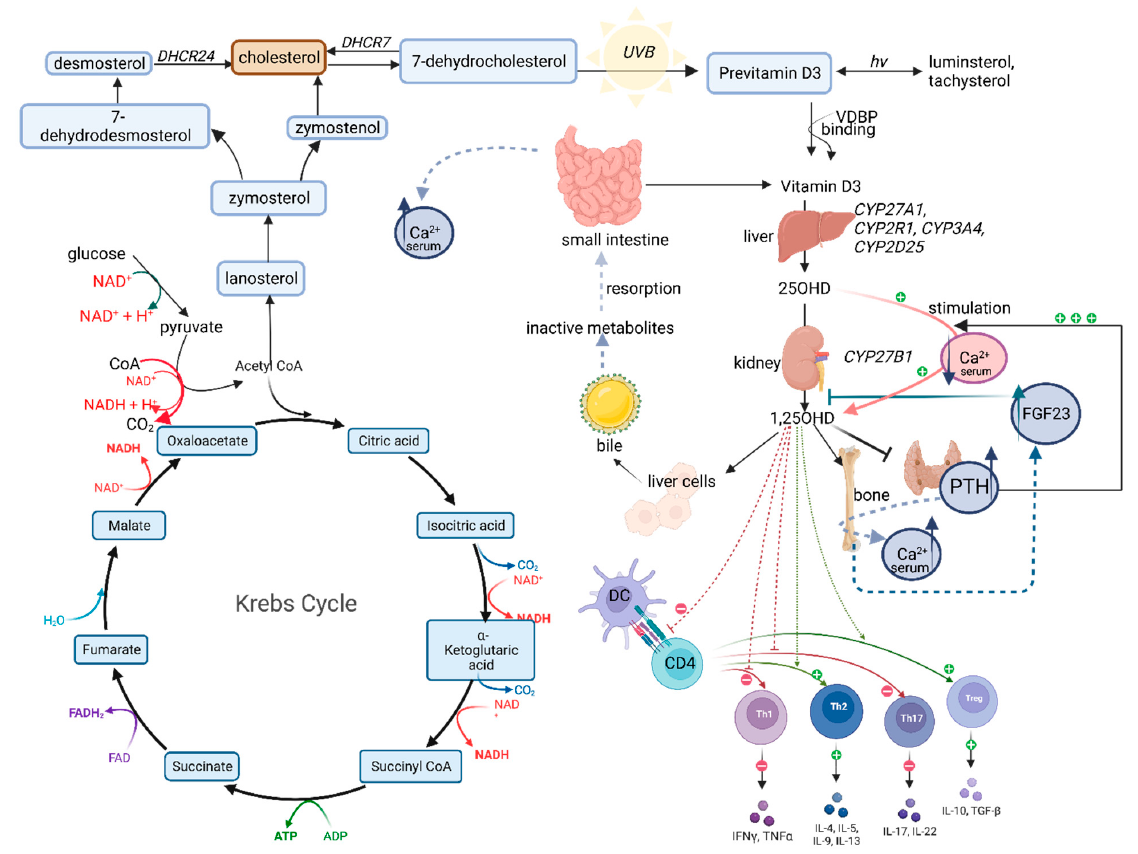
Figure 1. Metabolic pathway of vitamin D (created with BioRender.com, accessed on 18 September 2022).